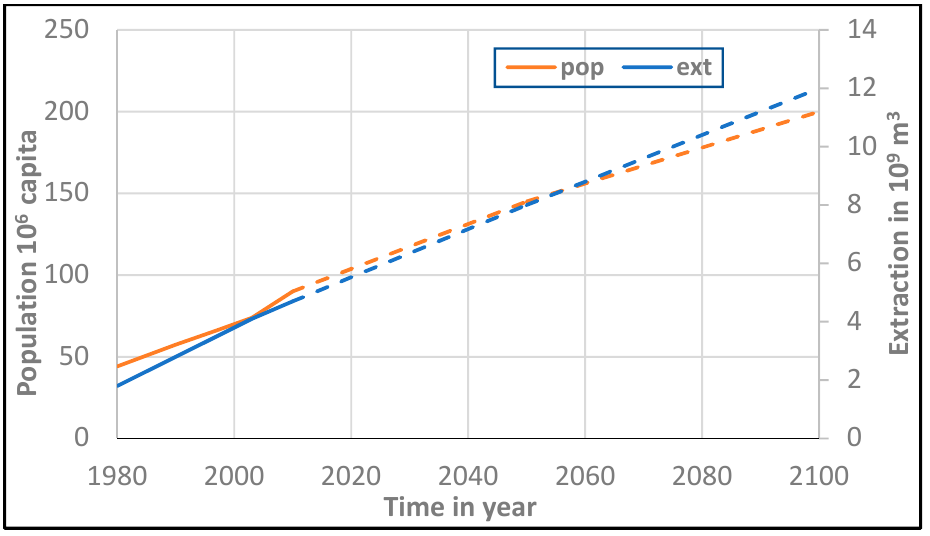
Figure 2. Population and groundwater extraction in the NDA as a function of time: current trend to 2010 (solid lines) and projections to 2100 (dashed lines) ([26]). Table 1. Future scenarios for sea-level rise (SLR) and groundwater extraction.